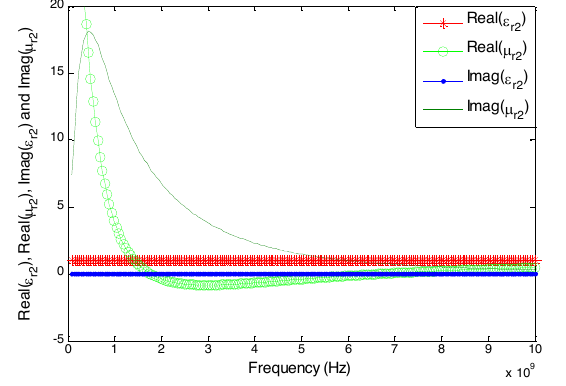
FIGURE 6. Real and imaginary parts of relative permittivity, ε r2 , and permeabilility, µ r2 , of Rings only media versus frequency for γ m = 4.78006 GHz, f mp = 8.34629 GHz, f mo = 1.4311 GHz